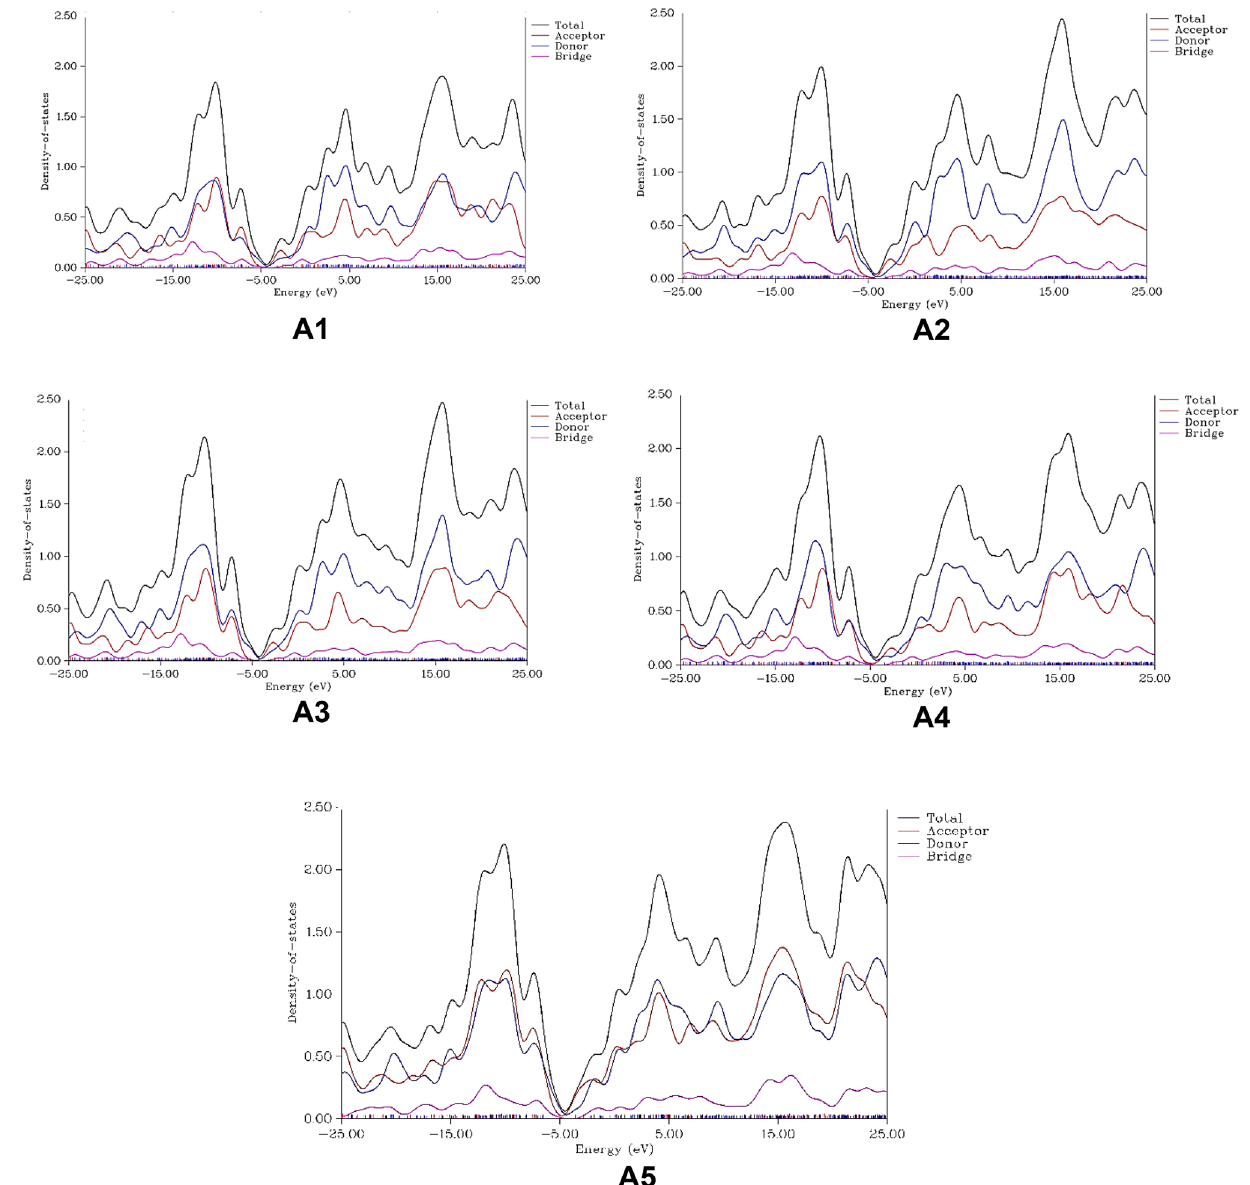
Figure 3. Total and partial density of states (PDOS) calculated at B3LYP/6-31G(d,p) for the designed molecules A1 – A5